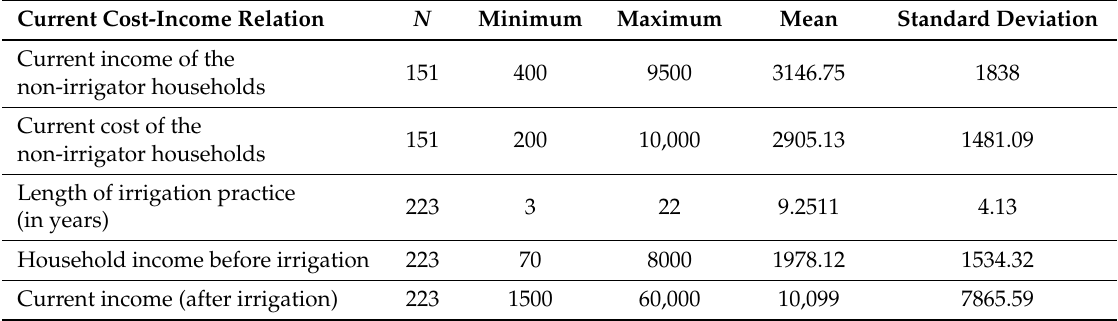
Table 4. Annual average income and cost of the non-irrigator HHs and annual average income of HHs before and after using irrigation in ETB (1 USD « 20